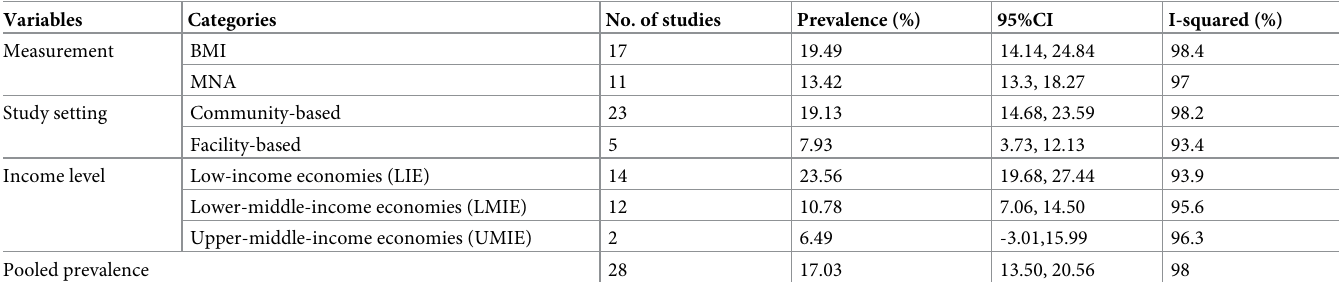
Table 2. Subgroup analysis of pooled prevalence of malnutrition among aged population in